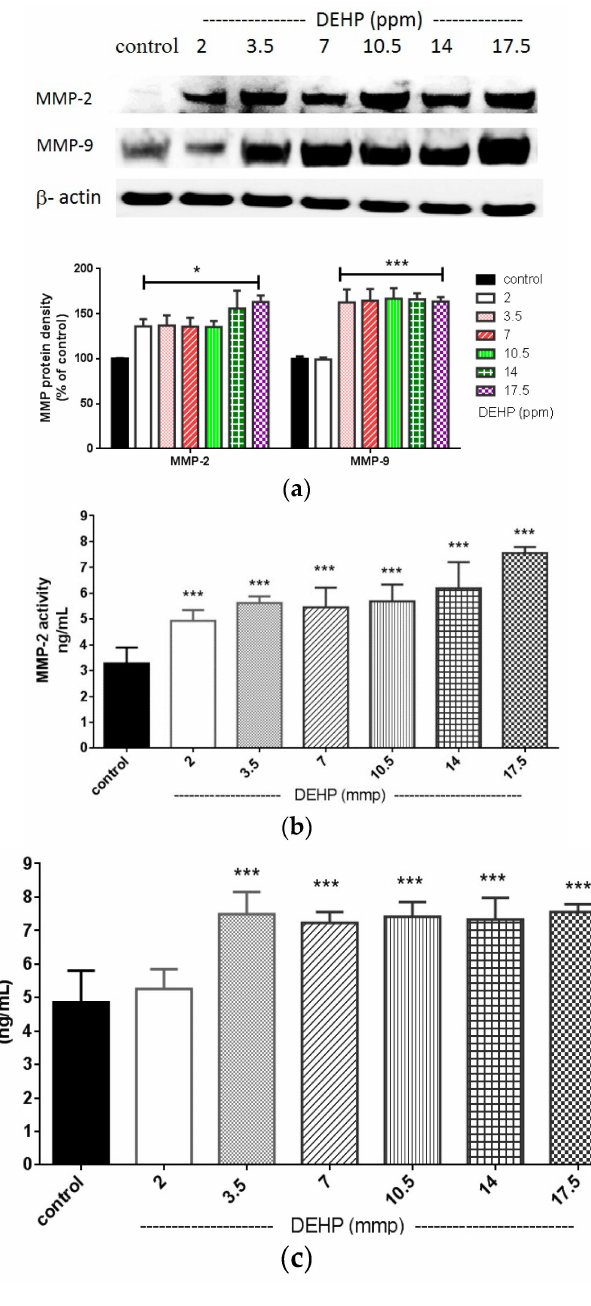
Figure 2. ( a ) Effects of DEHP on MMP-2 and MMP-9 protein expression. VSMC ( n ě 3) were treated with DEHP (concentrations between 2 and 17.5 ppm) for 24 h prior to MMP-2 and MMP-9 protein extraction and expression. Statistics are shown for DEHP-treated cells * p < 0.05 and *** p < 0.005, compared to the respective controls; ( b ) Effects of DEHP on MMP-2 activity. VSMC were treated ( n ě 8) with DEHP (concentrations between 2 and 17.5 ppm) for 24 h prior to MMP-2 activities being measured. Statistics are shown for DEHP-treated cells *** p < 0.005, compared to the control; and ( c ) Effects of DEHP on MMP-9 activity. VSMC were treated ( n ě 8) with DEHP (concentrations between 2 and 17.5 ppm) for 24 h prior to MMP-9 activities being measured. Statistics are shown for DEHP-treated cells *** p < 0.005, compared to the